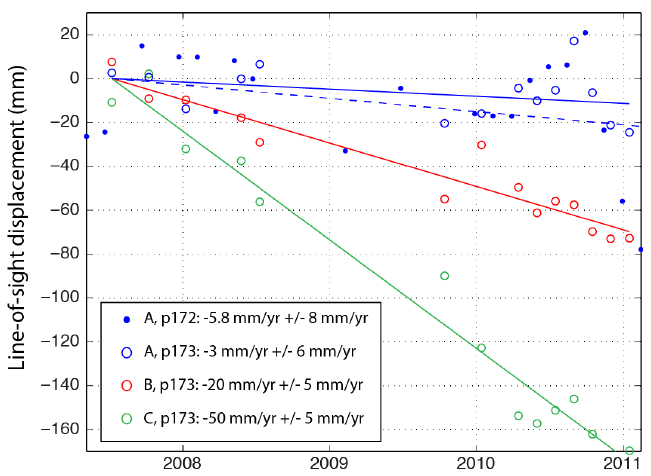
Figure 17. Time series and inferred errors on rates at points A–C indicated in Figure 16. Shortening is consistent with either uplift or westward displacement. Dashed lines and closed circles indicate results inferred from path 172, and solid lines and open circles indicate path 173. Error bounds are 95% confidence intervals based just on the fit of the points at an individual pixel and do not reflect the spatial correlations of the noise that are evident in Figure